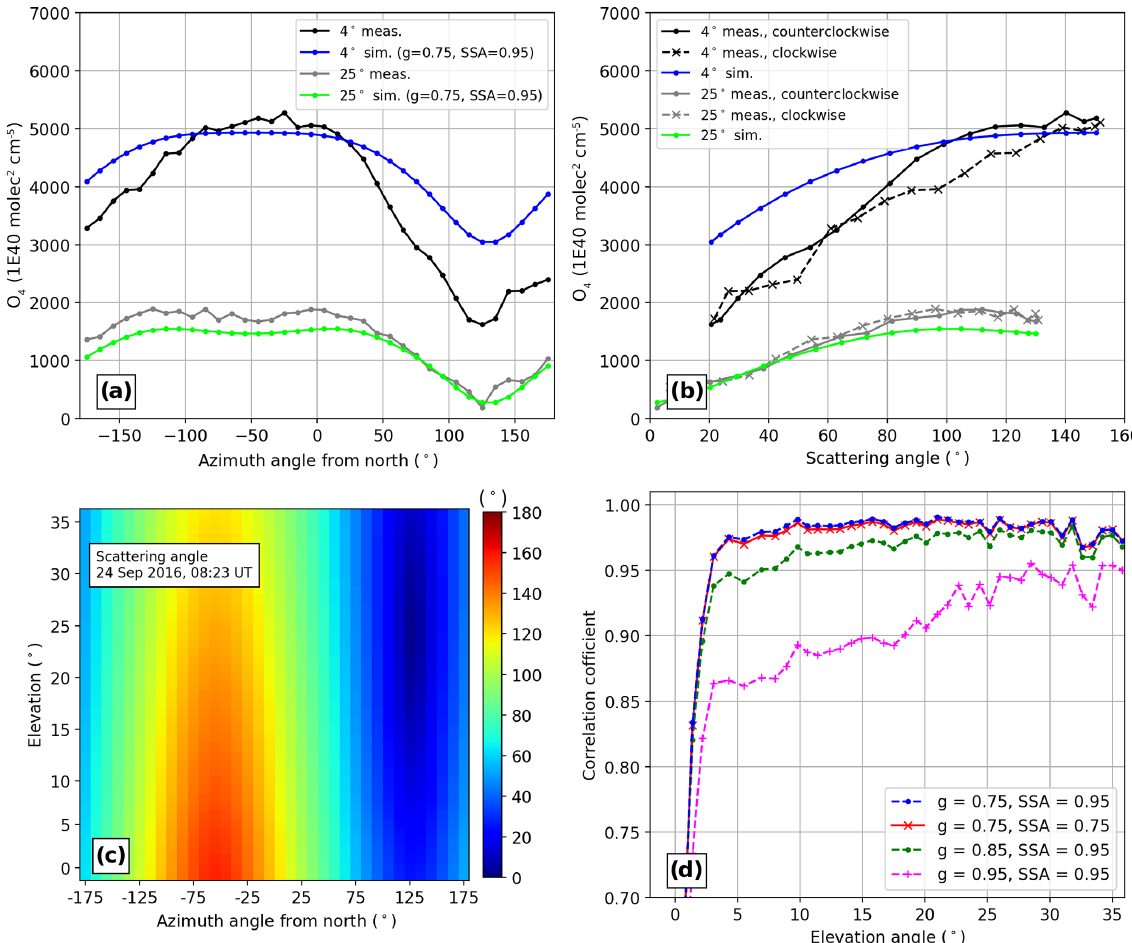
Figure 16. (a) Measured and simulated almucantar scans of O 4 DSCDs on 24 September 2016 in two exemplary elevation angles (4 ◦ is close to the surface, and 25 ◦ is the solar almucantar), i.e., horizontal cross sections through Figs. 15b and d. (b) Same data plotted as a function of the (single) scattering angle shown in (c) , which has been calculated for every viewing geometry of the hemispheric scan in Fig. 15. (d) Correlation coefficients between measured and simulated almucantar O 4 DSCDs for all elevation angles (i.e., all data from Fig. 15). Different input parameters (asymmetry factor g and single-scattering albedo, SSA) have been used for the simulation of O 4 DSCDs (for simulated data in subplots a and b, g = 0 . 75 and SSA = 0.95 have been